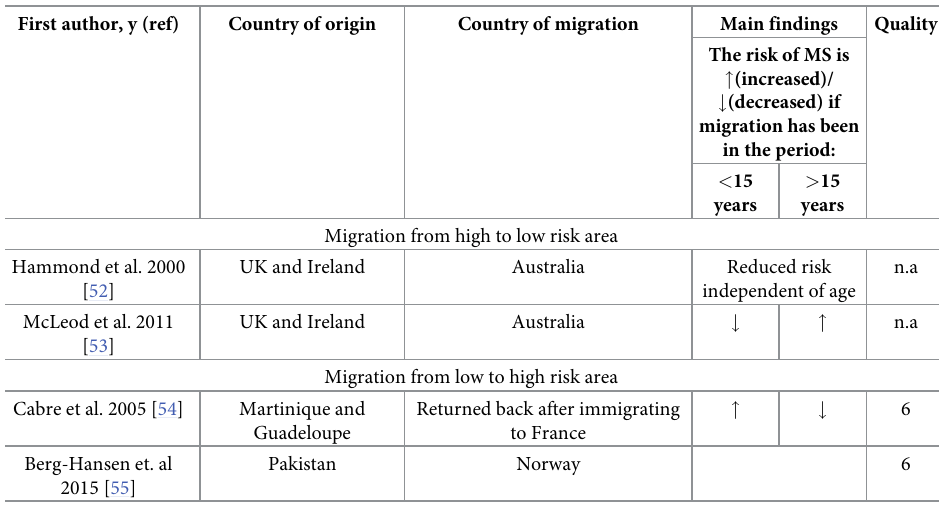
Table 4. The risk difference in developing MS between early and late age at